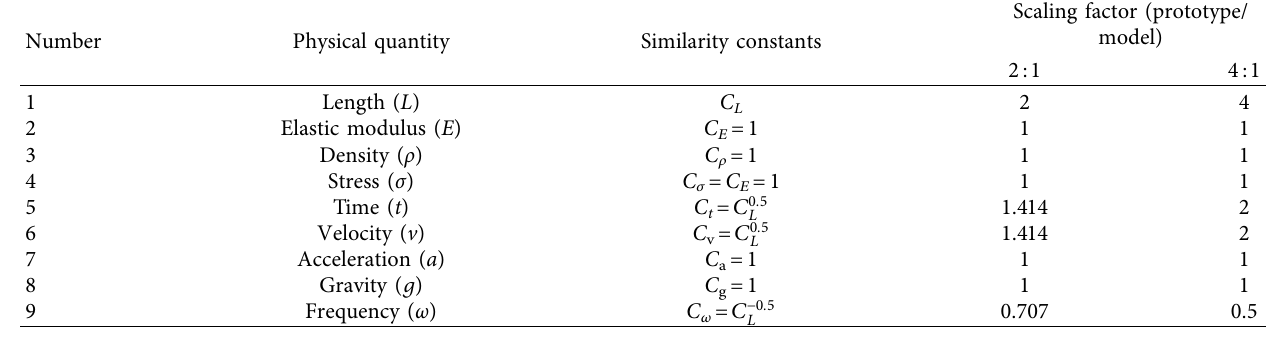
Table 2: Scaling factors in the specimen.